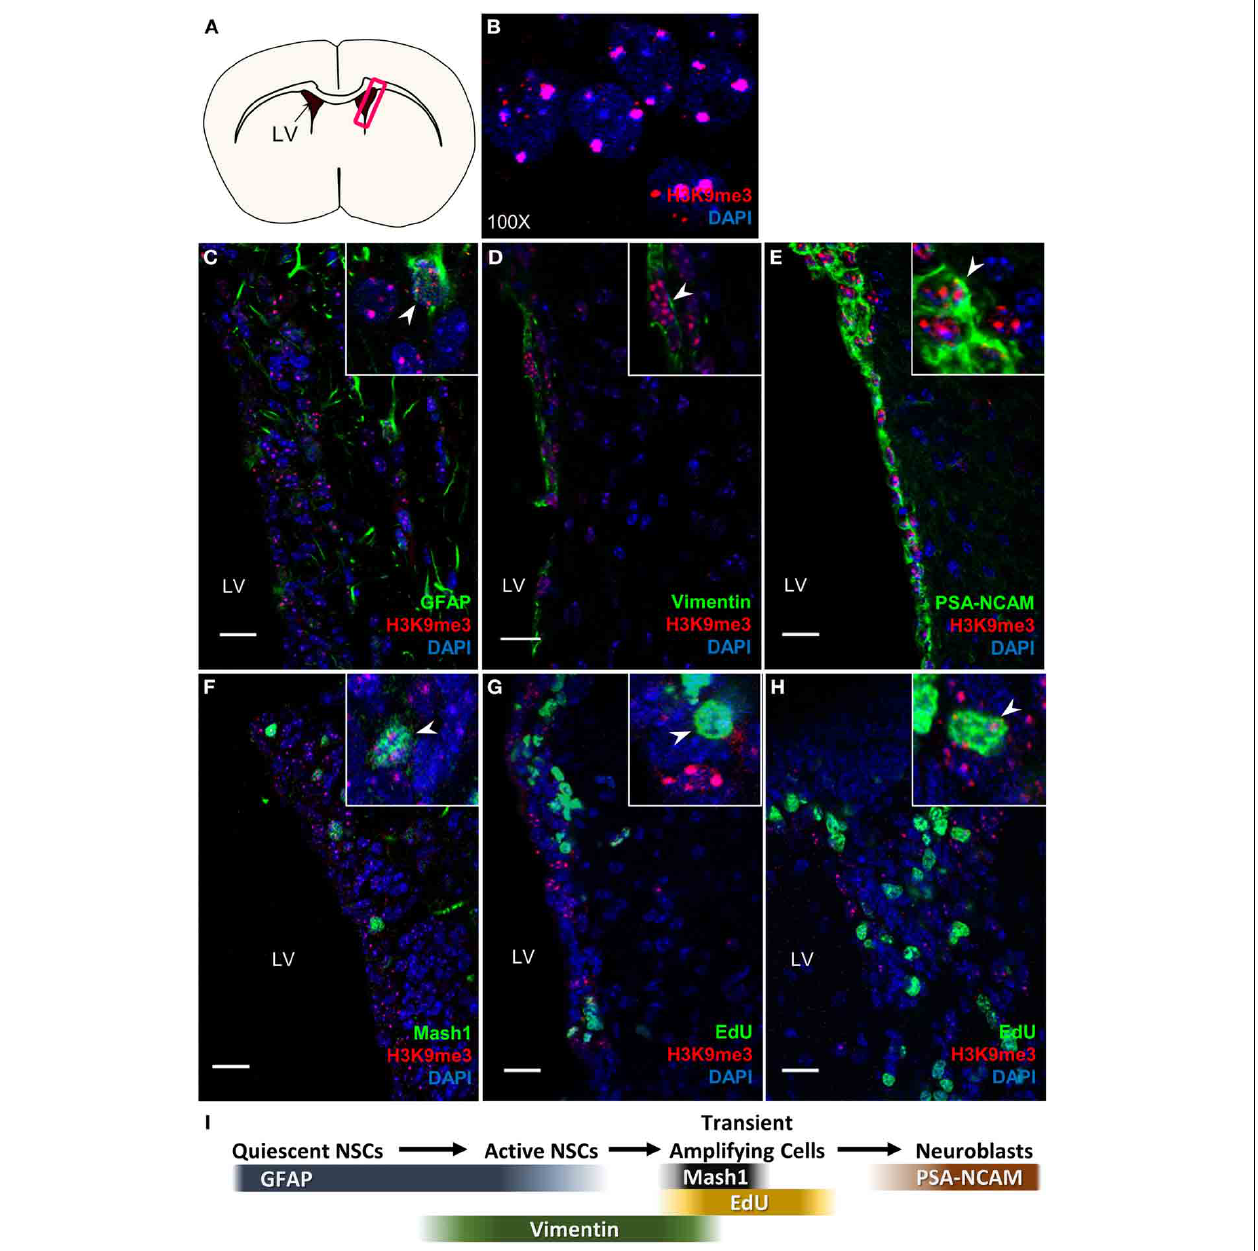
FIGURE 1 | H3K9me3 distribution in mouse SVZ. (A) Coronal cross-section view of mouse forebrain, box indicates location of SVZ. (B) H3K9me3 staining pattern in SVZ cells (100X). (C–E) Double labeling of H3K9me3 (red) and SVZ cell-type specific markers: (C) NSC marker—GFAP; (D) Active NSC cell marker—Vimentin; (E) Neuroblast marker—PSA-NCAM. (F) Small